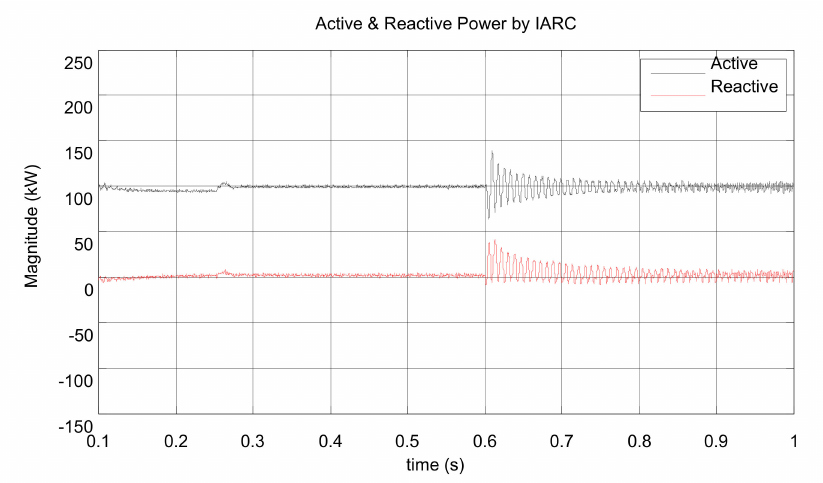
Figure 25. Injected instantaneous power into the grid under ‘type B’ voltage